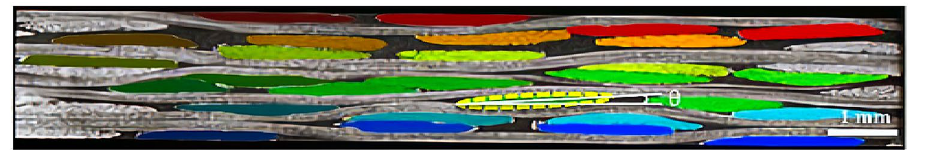
Figure 3. MicroCT image of polyester fabric 5 .